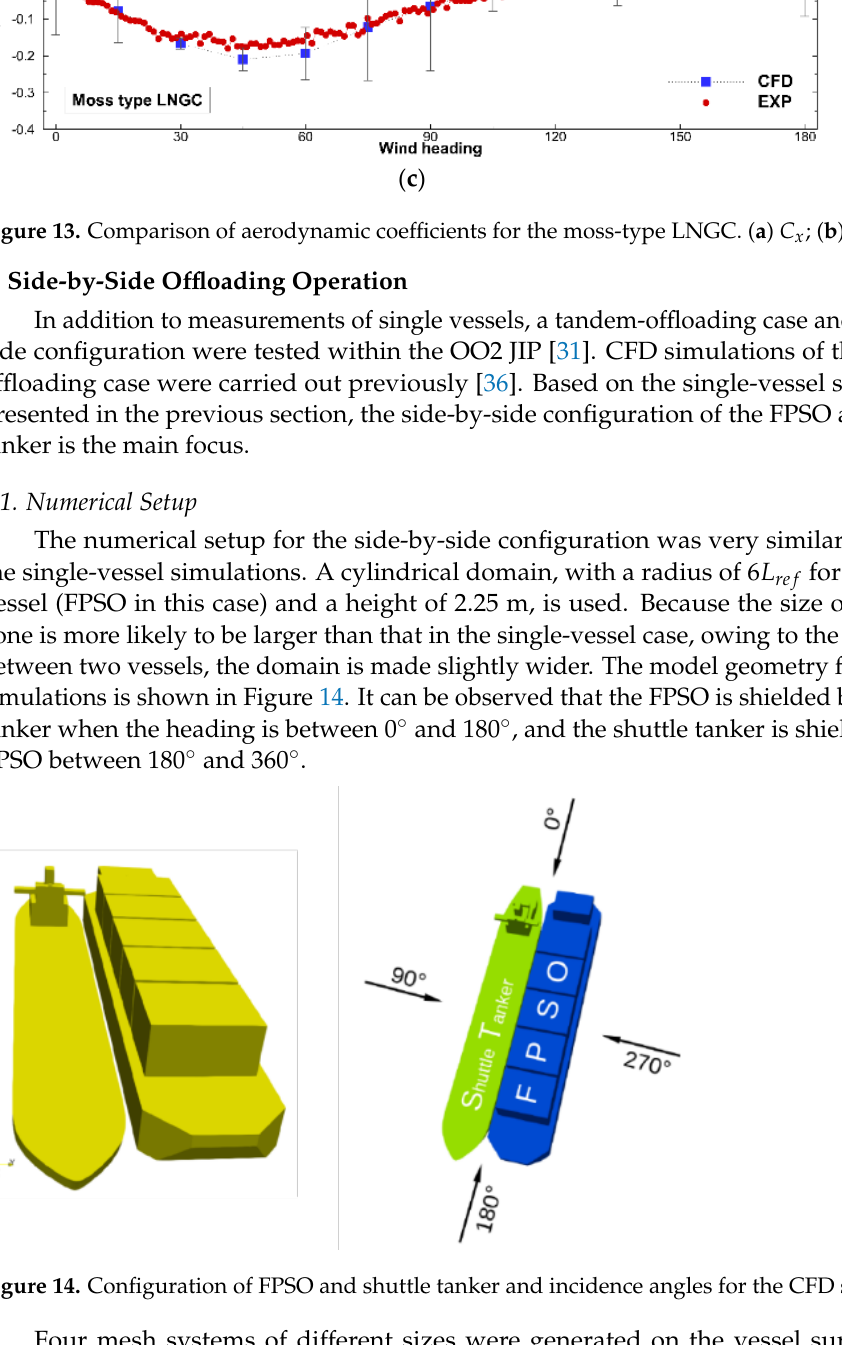
Figure 13. Comparison of aerodynamic coefficients for the moss-type LNGC. (a) 𝐶 𝑥 ; ( b ) 𝐶 𝑦 ; ( c ) 𝐶 𝑚 .